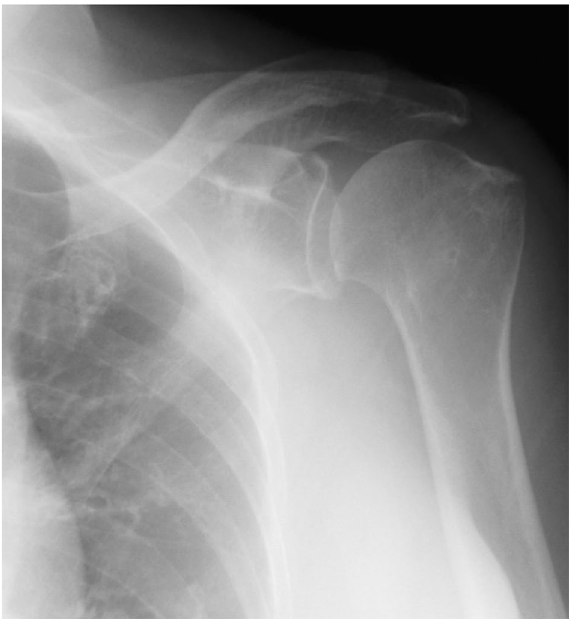
Figure 2. The figure shows the anteroposterior radiograph of Samilson-Prieto grade 1.